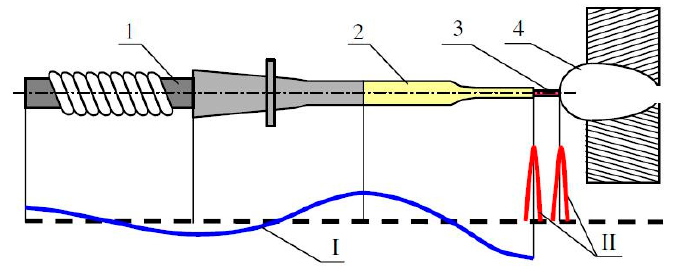
Figure 3. Schematic diagram of Esonix Ultrasonic Impact Treatment (UIT) (1—magnetostrictive transducer, 2—waveguide, 3—indenter, 4—treated surface, I—ultrasonic oscillations, II—impact impulses) [20] (Reproduced with permission from Elsevier, 2006). Table 3. Parameters of the UPT. Figure 2. Photograph of UPT device.